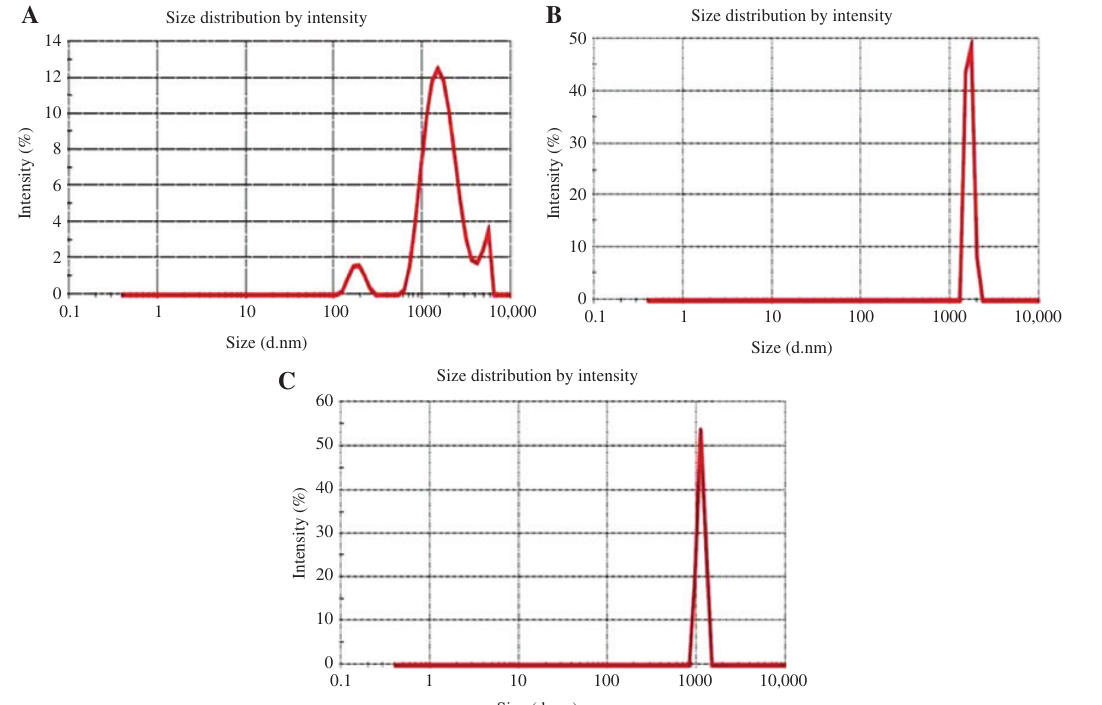
composites fabricated at 10 min AT and HTs of (A) 20 min, (B) 30 min, and 2